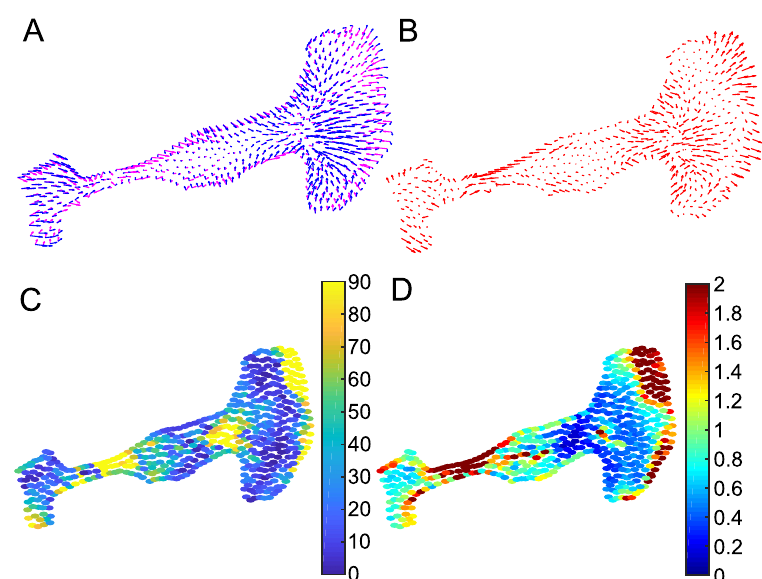
Fig 6. Comparing predicted forces to experimental data for a polarized cell. (A) Predicted CPM force fields (magenta arrows) and experimental data (blue arrows) (B) Difference of CPM force field and experimental force field (C) directional deviation (angle between predicted and experimentally observed force vectors), dark blue means forces align well. (D) relative magnitudes of the force fields, green means similar magnitude. Parameter values are given in Table S2 Table. See also S12, S13 and S16 Figs.